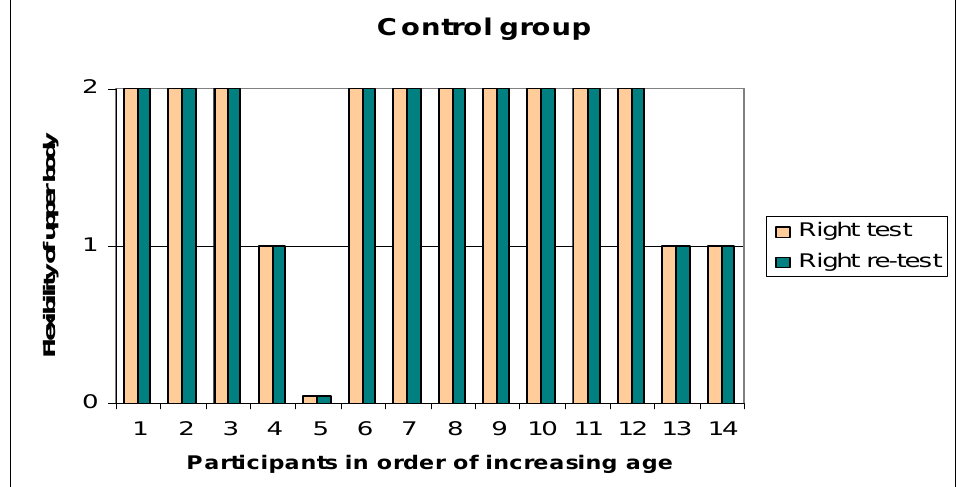
Figure 8 . For the classification of arm ROM, see legend to Figure